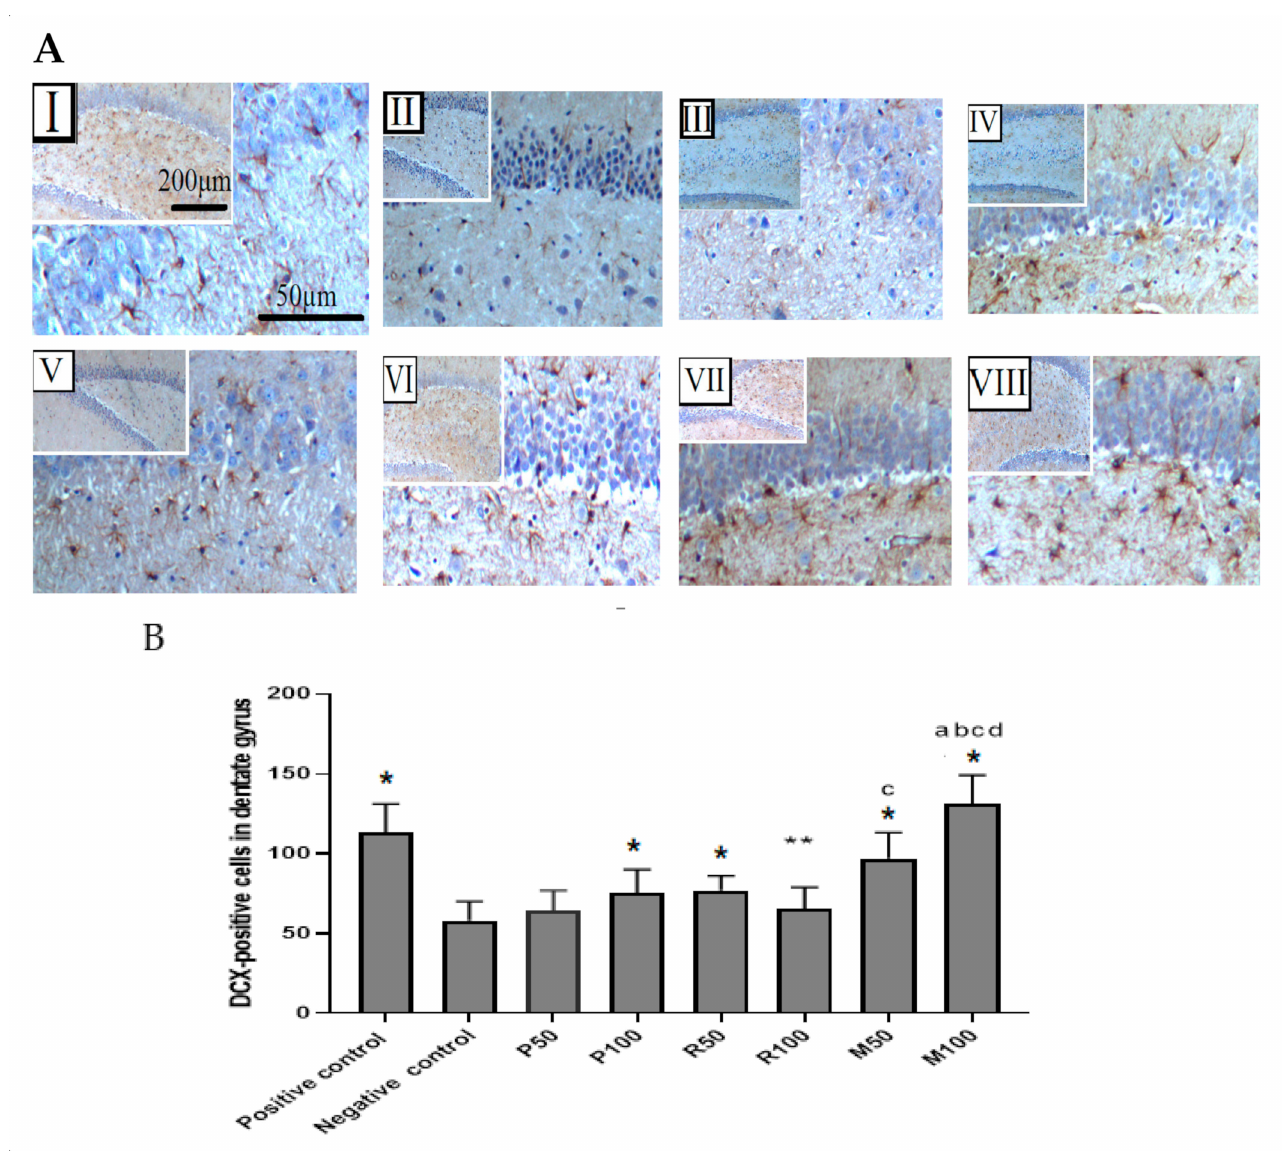
Figure 8. Immunohistochemical findings for both extracts ( Rosmarinus officinalis and Mentha piperita ) during the enhancement of neurogenesis in the dentate gyrus after scopolamine-induced suppression. ( A ) Coronal sections of rat’s hippocampal tissues. Immature neuronal cells with DCX-positive staining in the SGZ of the dentate gyrus. Photomicrographs of the dentate gyrus groups: ( I ) Positive control, ( II ) Negative control, ( III ) P50, ( IV ) P100, ( V ) R50, ( VI ) R100, ( VII ) M50, ( VIII ) M100. Magnifications of photomicrographs are at 40 × and 100 × . ( B ) Bar graphs represent the quantification of total DCX- positive cells in the SGZ of dentate gyrus ( n = 6). Data are presented as mean ± standard deviation (SD), and statistical analysis was performed by one-way ANOVA followed by Tukey’s post-hoc test, * p < 0.05 and ** p < 0.01 a = significant result with P100, b = with P50, c = with R100, d = with R50. Comparison was between positive groups and all treatment groups with the negative